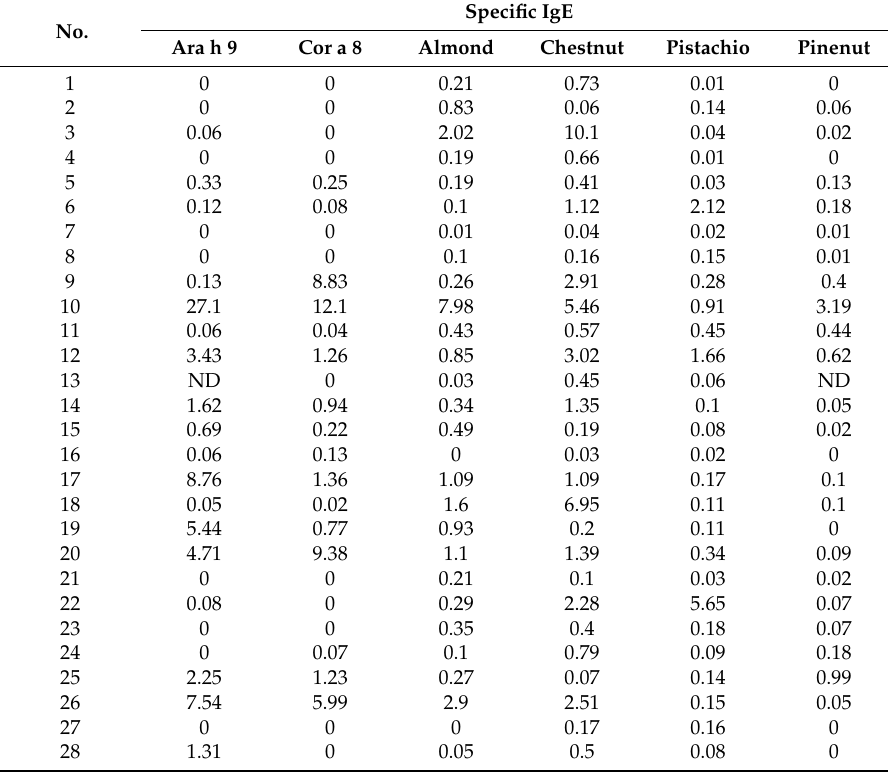
Table 4. Nut allergic patients from